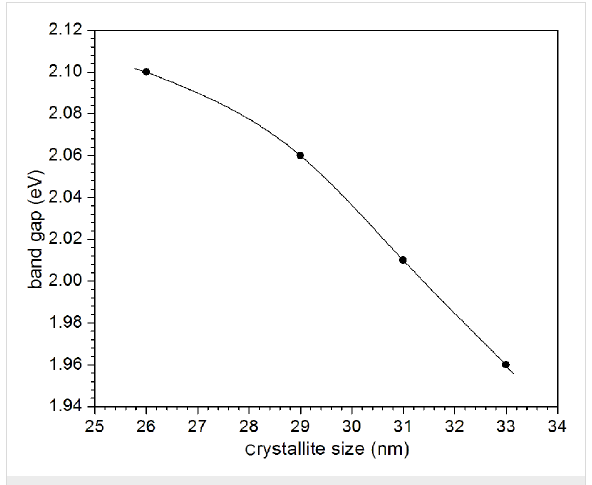
Figure 8: Variation of the band gap with crystallite size of PbSe thin